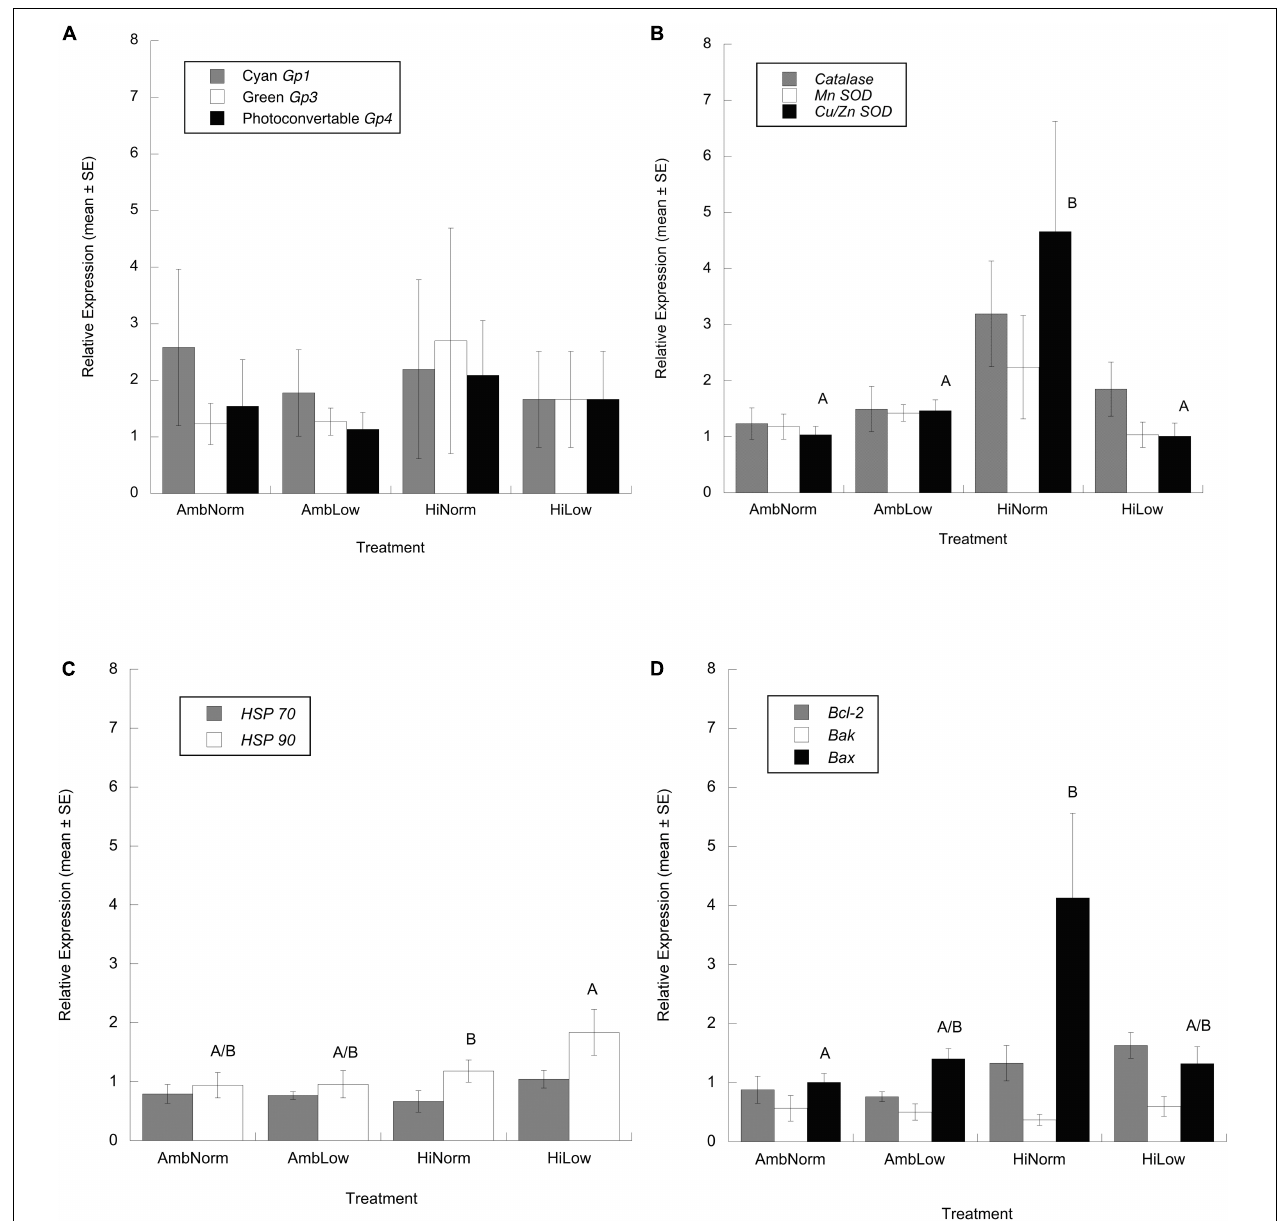
FIGURE 3 | Relative expression ratios, or fold changes, of target and housekeeping gene transcripts (mean ± SE) for Montastraea cavernosa host as determined by qPCR. (A) Fluorescent proteins. (B) Antioxidant enzymes. (C) Heat shock proteins. (D) Regulators of apoptosis. Common superscripts indicate treatment groups not significantly different from each other (Tukey’s HSD, P > 0.05, panels C,D and Dunnett’s Method, P > 0.05, panel B